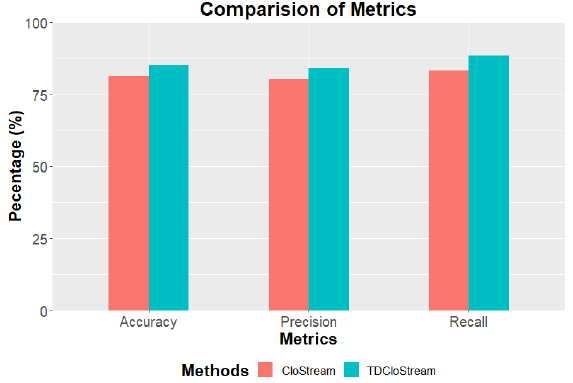
Figure 3. User anomaly behavior